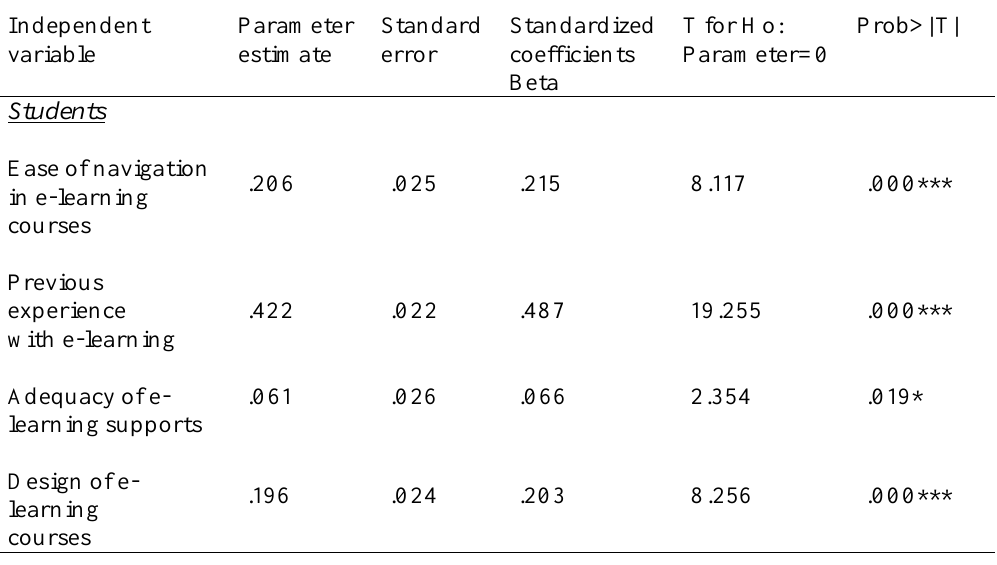
Regression Analysis – Dependent Variable: Adequacy of E-learning Skills Independent variable